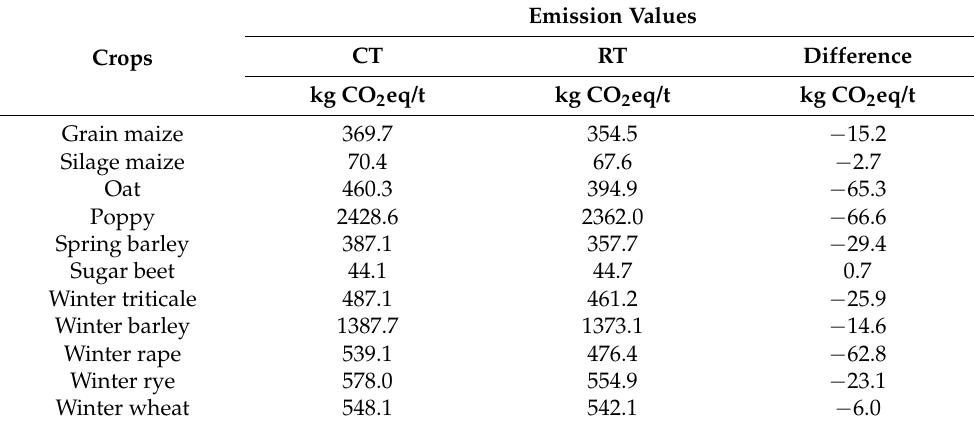
Table 2. GHG emissions as CO 2 eq by CT and RT